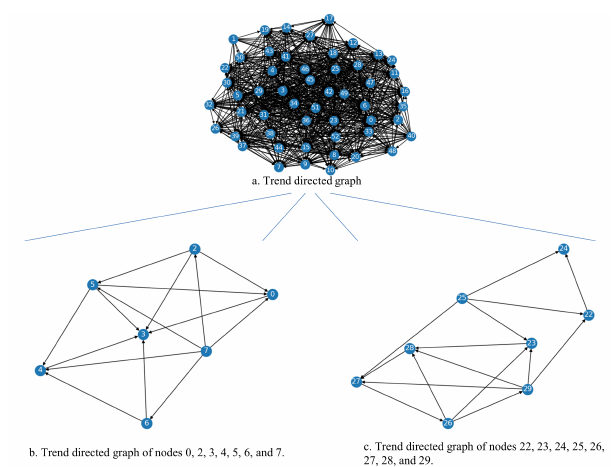
Figure 13. Trend